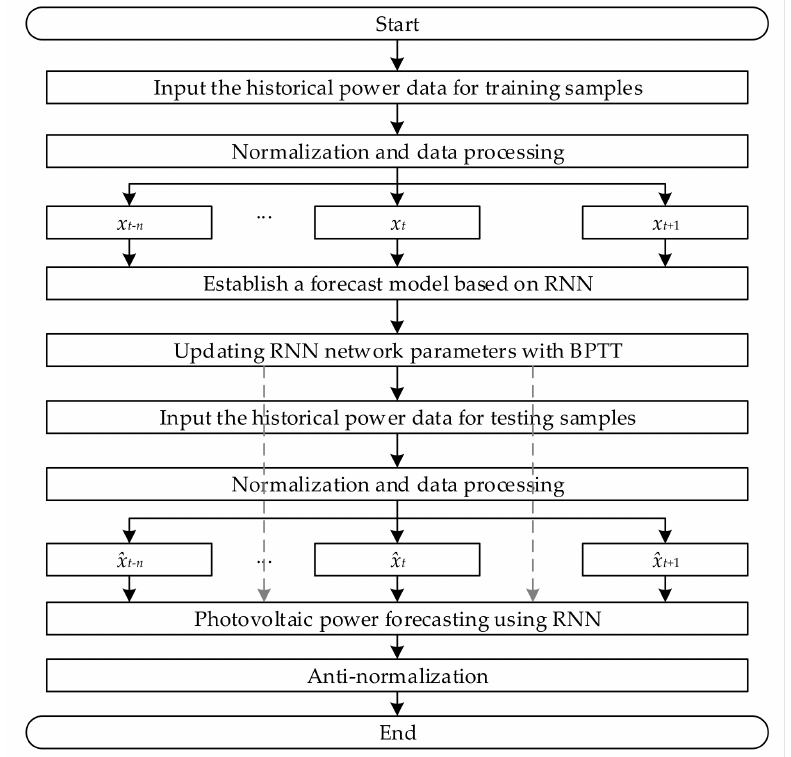
Figure 5. The flowchart for the PV generation power